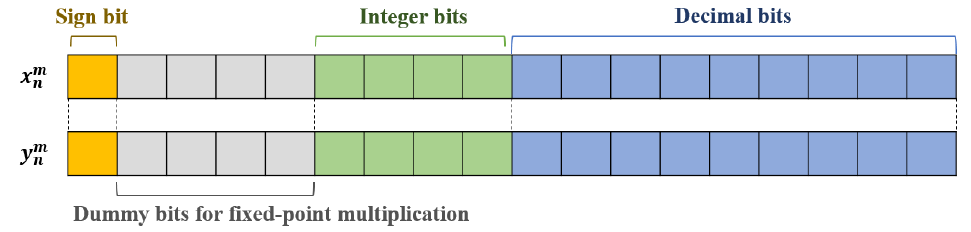
Figure 4. The concept of the fixed-point vector definition in the field-programmable gate arrays (FPGA)-based real-time MCO (FRMCO). Table 2. The main differences between the conventional MCO and the FRMCO.